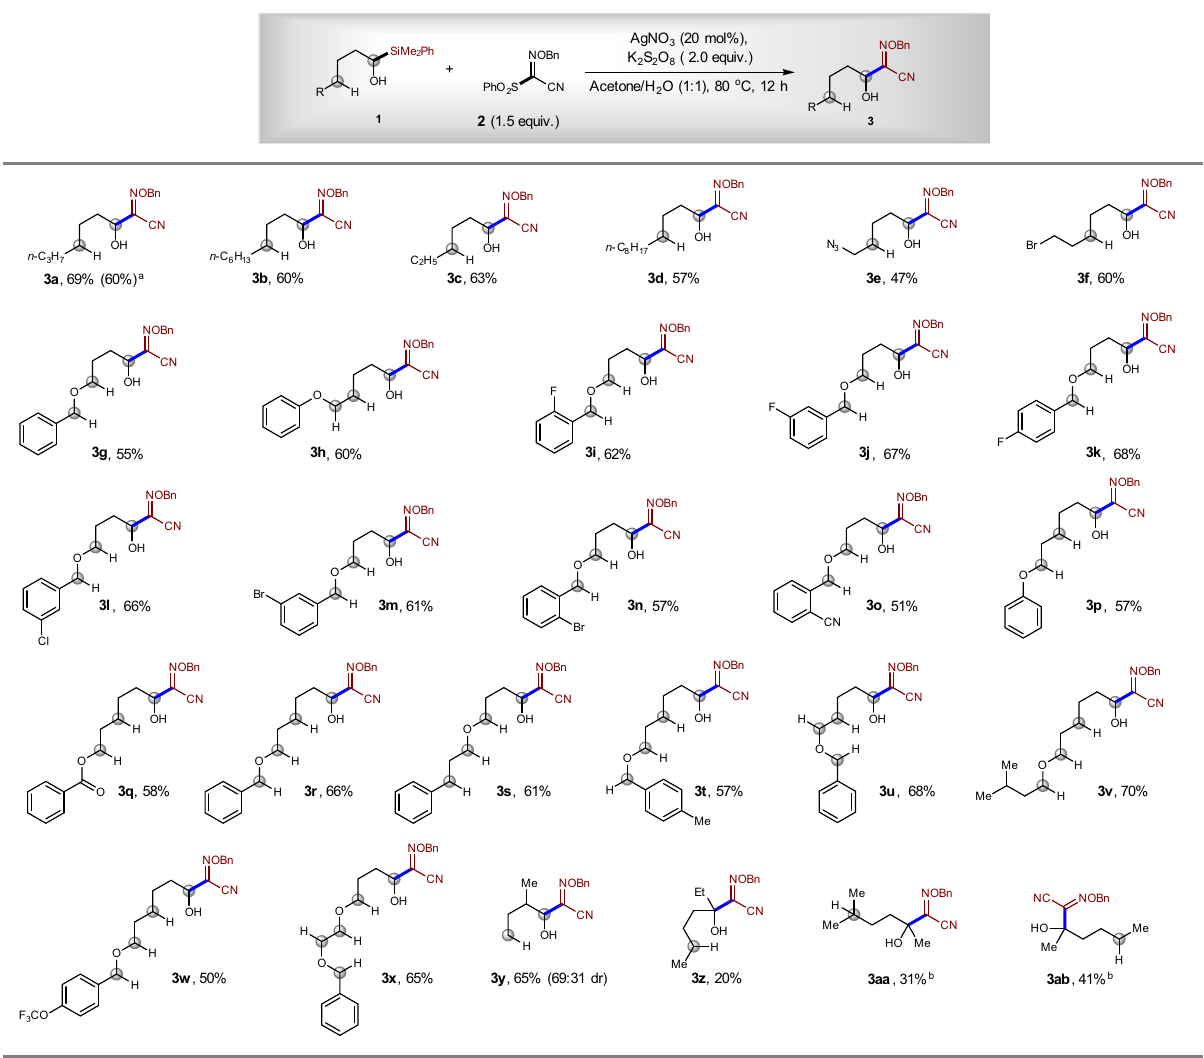
Fig. 7 Scope for the synthesis of α -alkoxylimino alcohols. a The yield in the parentheses refers to the isolated yield of the gram-scale reaction. b Acetone/ H 2 O (v/v = 2:1) was used as the solvent.